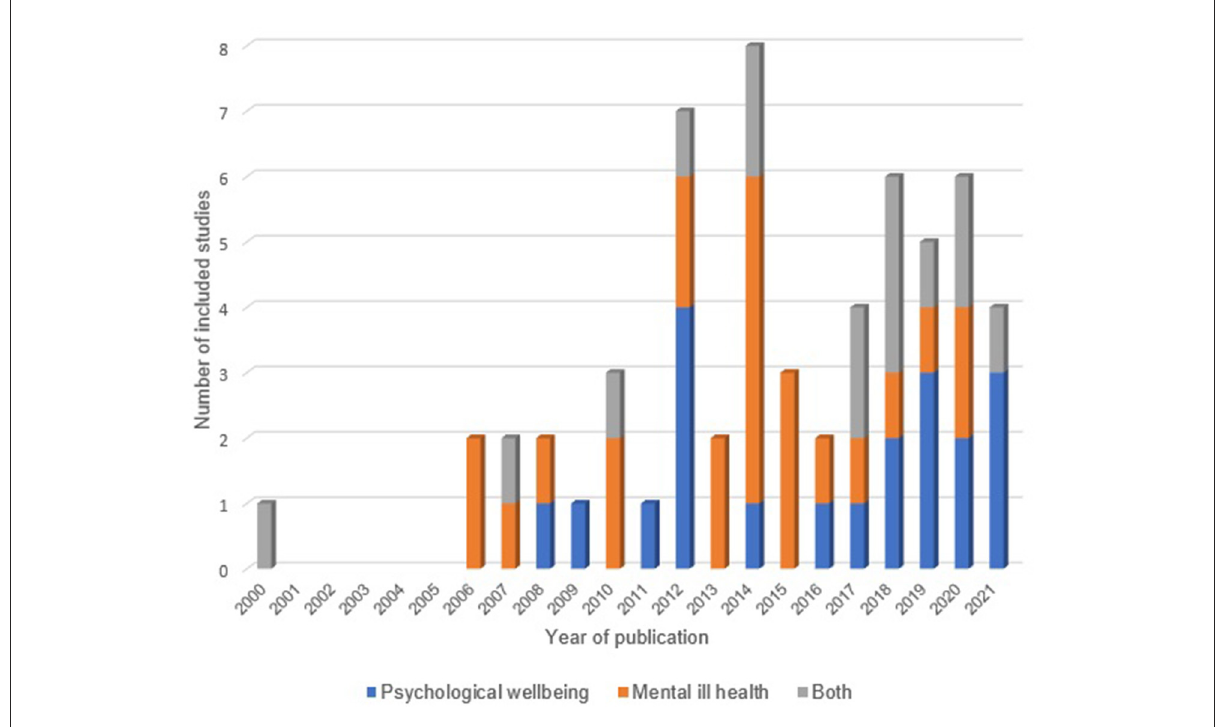
FIGURE2 Number of included RCTs per year by type/s of outcome measured ( n =